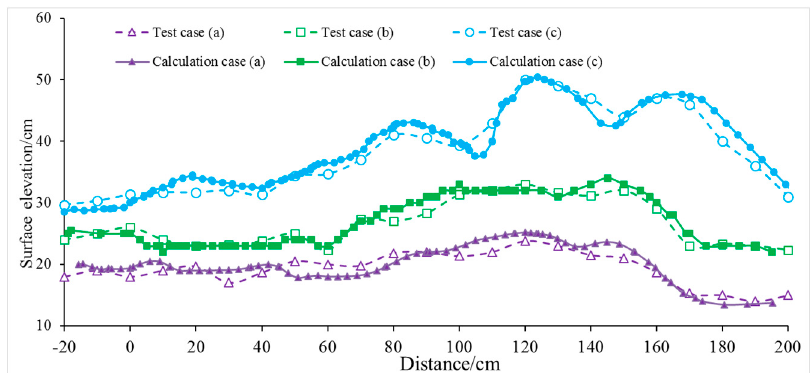
Figure 3. Schematic diagram for flow regimes under three cases.